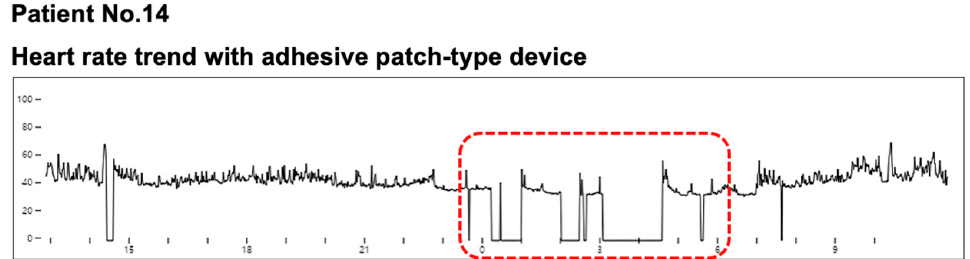
Figure 6. The heart rate trend with adhesive patch-type ECG monitoring device. The raw data from the outlier with significantly higher total QRS complexes with Holter monitoring showed there were significant Bluetooth disconnection periods during the nocturnal period (within the red-rectangled area). Abbreviations: ECG, electrocardiogram.